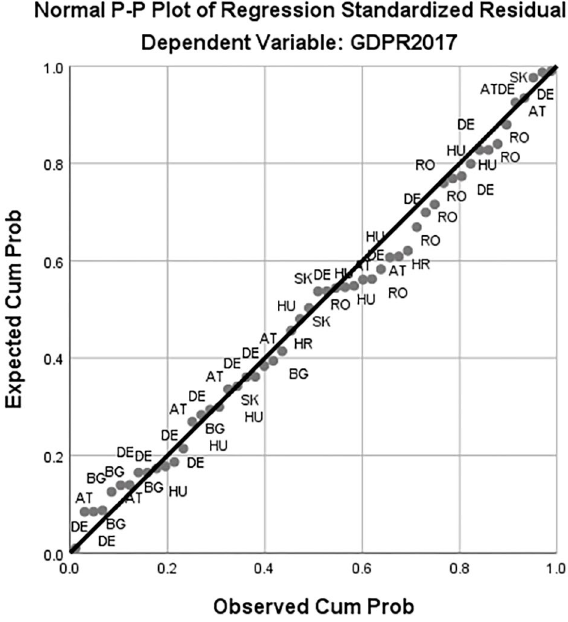
Figure 6. P-P Plot for sustainable development of EUSDR in